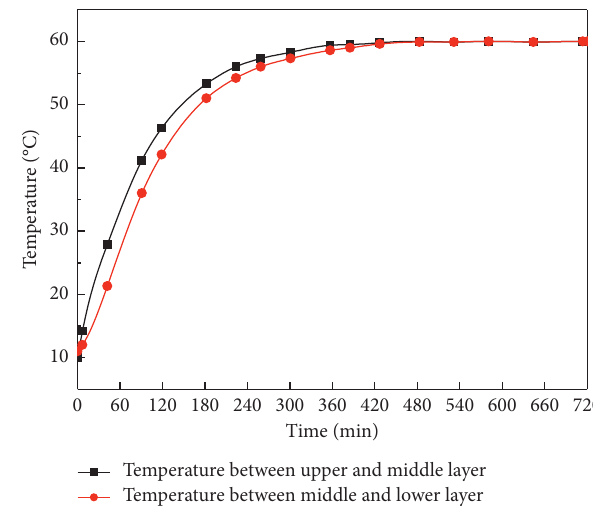
Figure 4: Relationship between the internal temperature and holding time of the slab specimen.